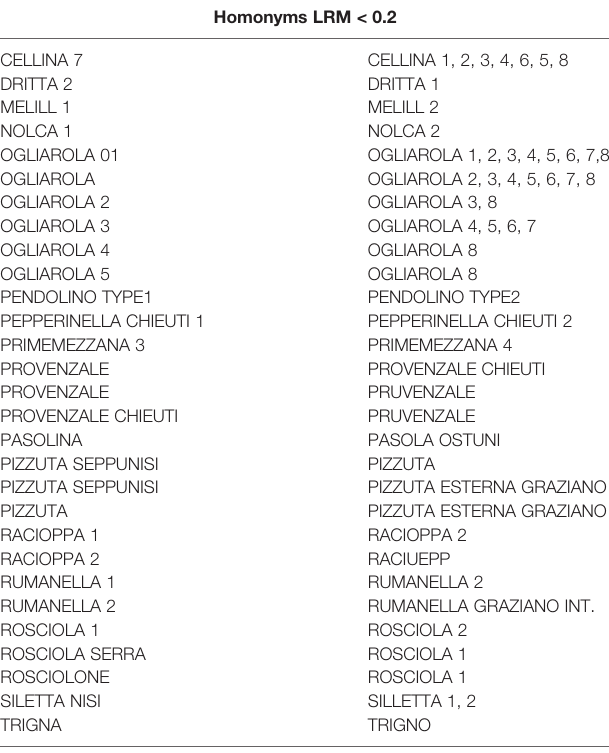
The population structure indicated a maximum for D K at K = 2 ( Supplementary Figure 2 ), separating the national Italian germplasm from the local varieties under investigation ( Supplementary Figure 2A ).